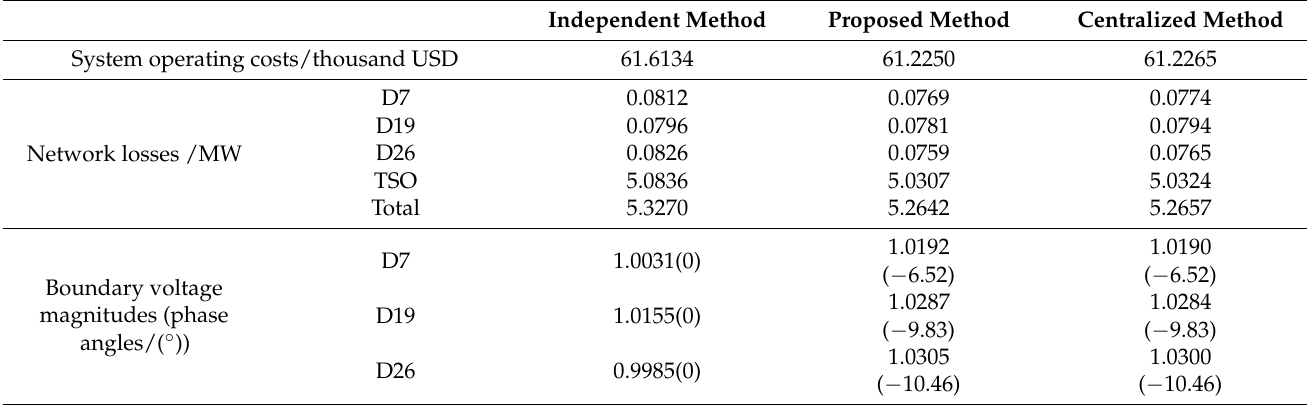
Table 3. Comparison of the results of solving test case 2 by different methods.